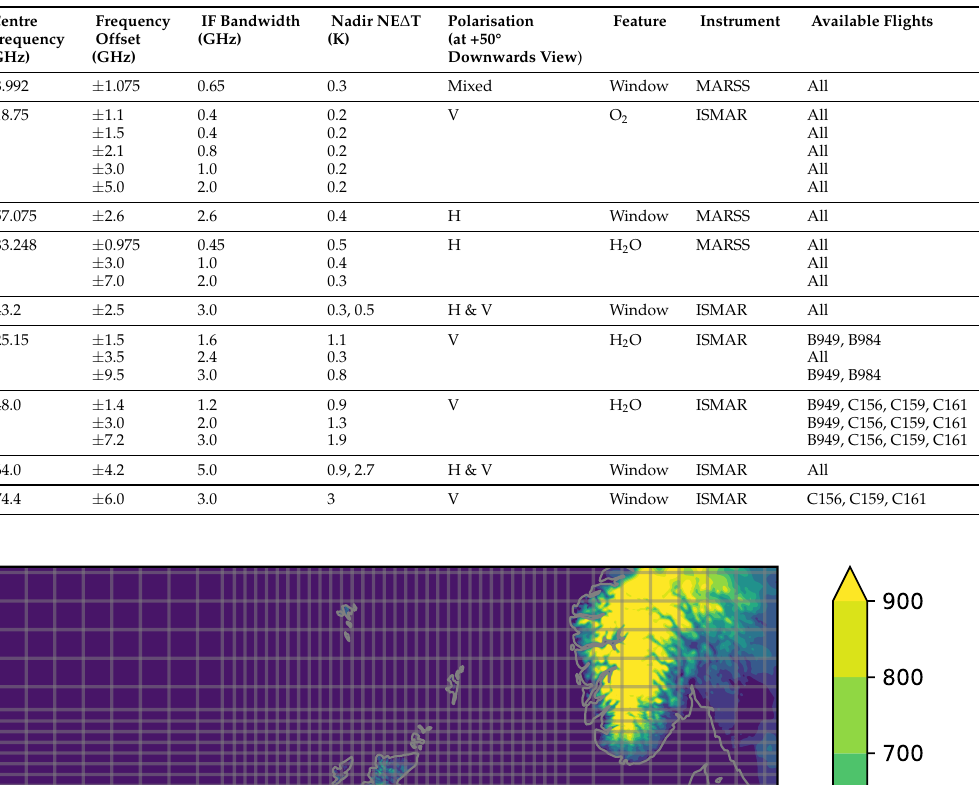
Table 1. ISMAR and MARSS channels used in this study. The column labelled NE ∆ T gives the channel noise-equivalent ∆ T, i.e., the brightness temperature difference that produces a change in signal equal to the radiometer noise level. The NE ∆ T quoted for the 874 GHz receiver is an estimate from clear-sky flight data.